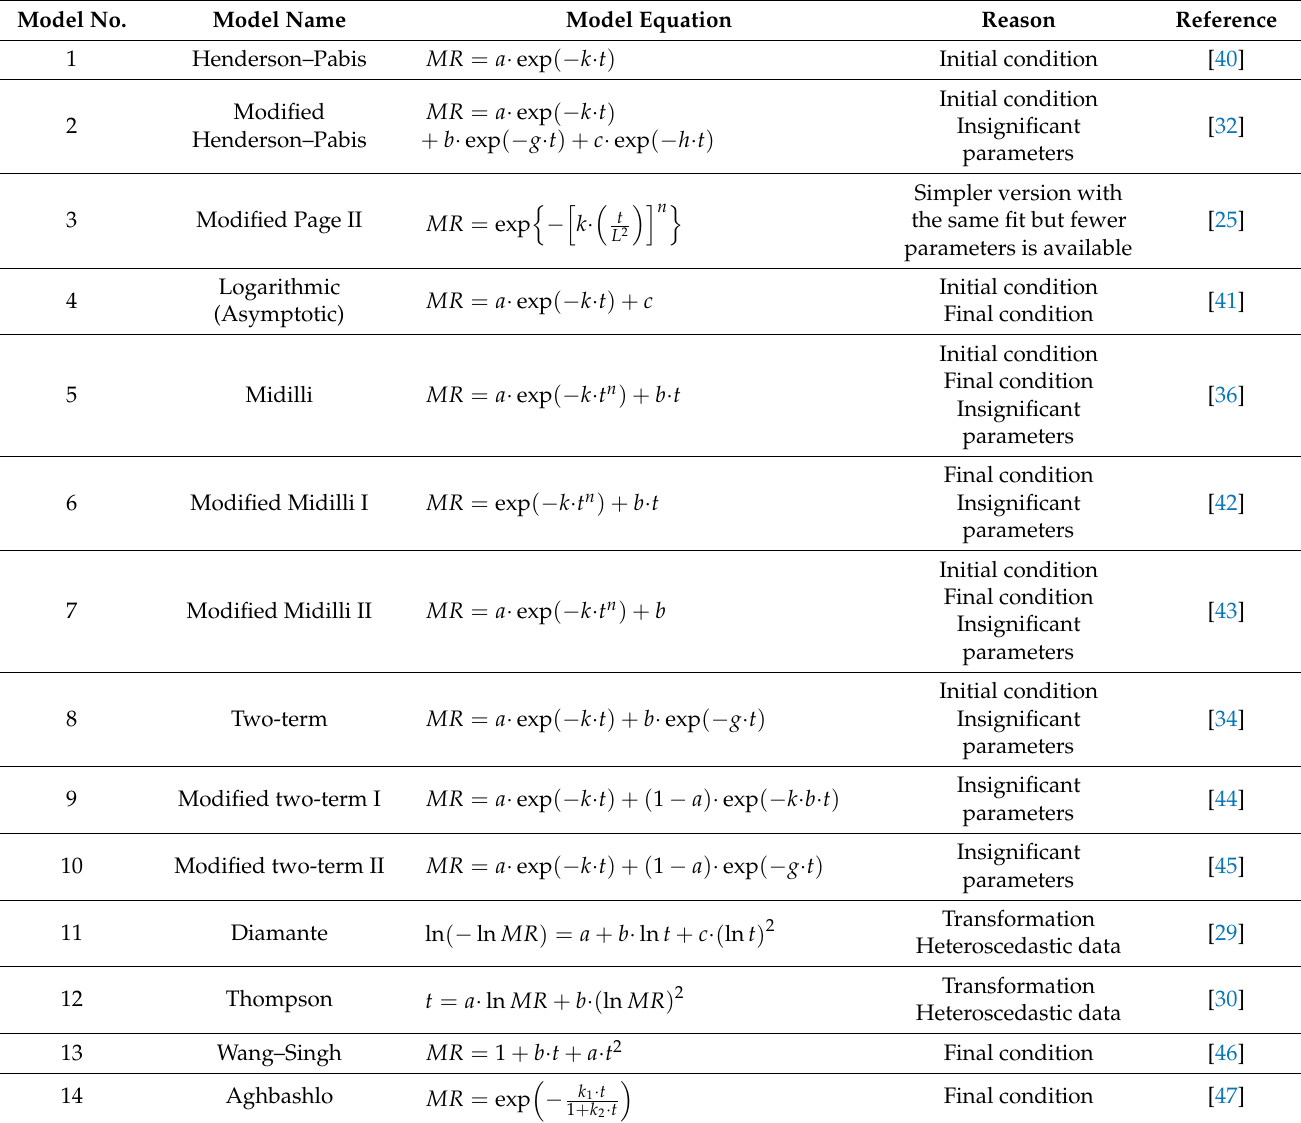
Table 5. Eliminated thin-layer drying models and the reasons for this